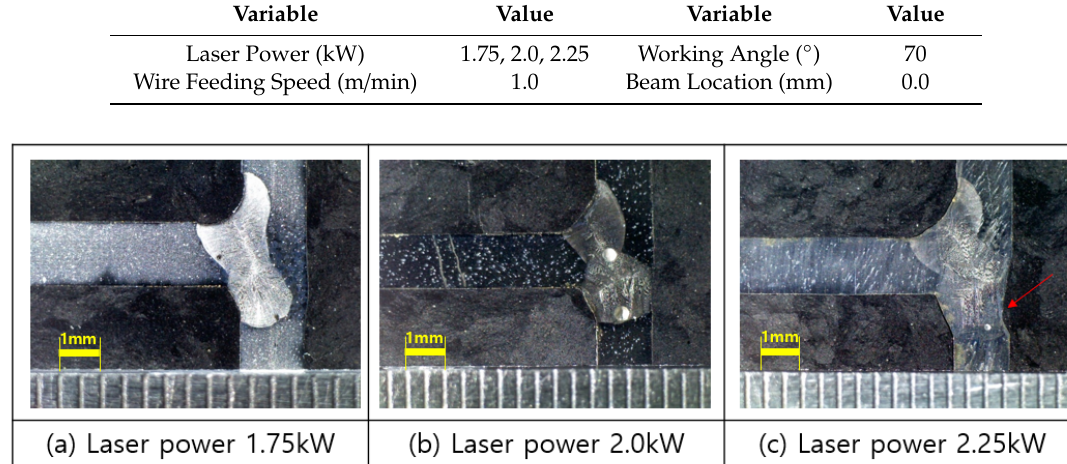
Figure 6. Difference among working angles. Figure 6. Di ff erence among working angles.